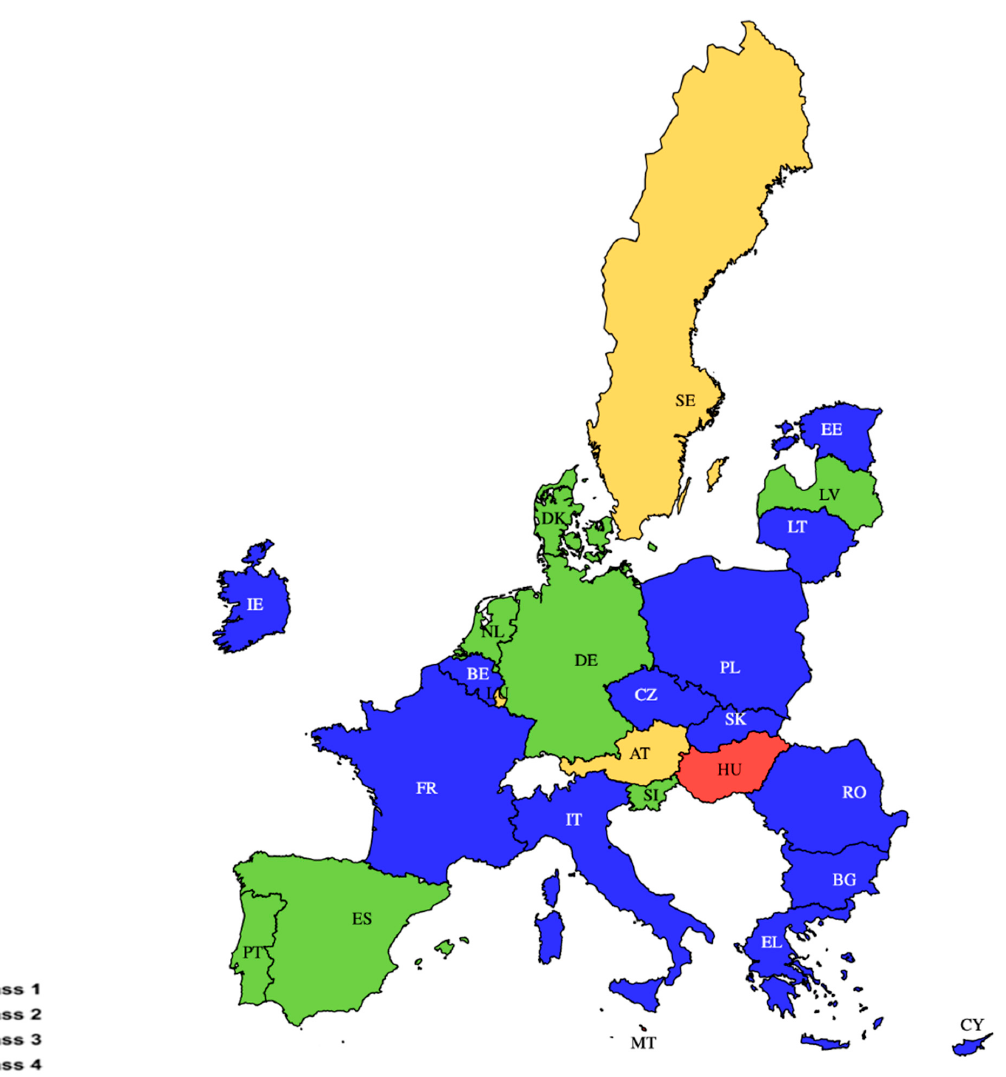
Figure 5. EU countries by typology in 2010.